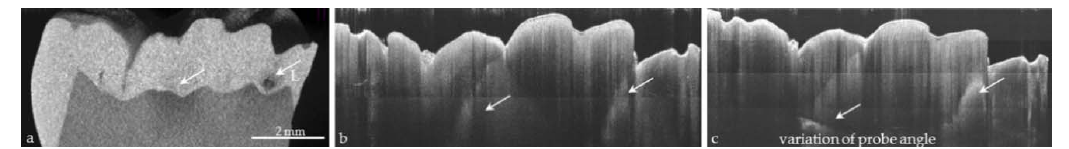
Figure 8. Extracted human molar with occlusal carious lesions without cavitation (L, arrow). ( a ) μ CT image of a ROI as reference; ( b ) Bright signals show extended lesion areas (arrows); ( c ) The varying of the OCT probe angle provides increased OCT signals and additional information about dentin involvement.